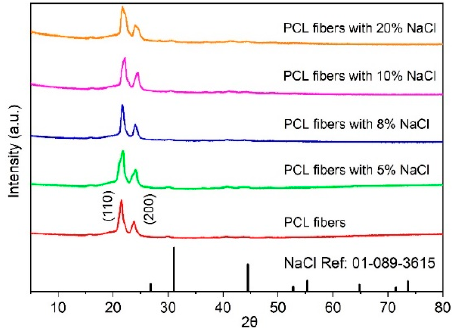
Figure 4. The XRD patterns of the PCL fiber and the PCL fiber with NaCl additive.